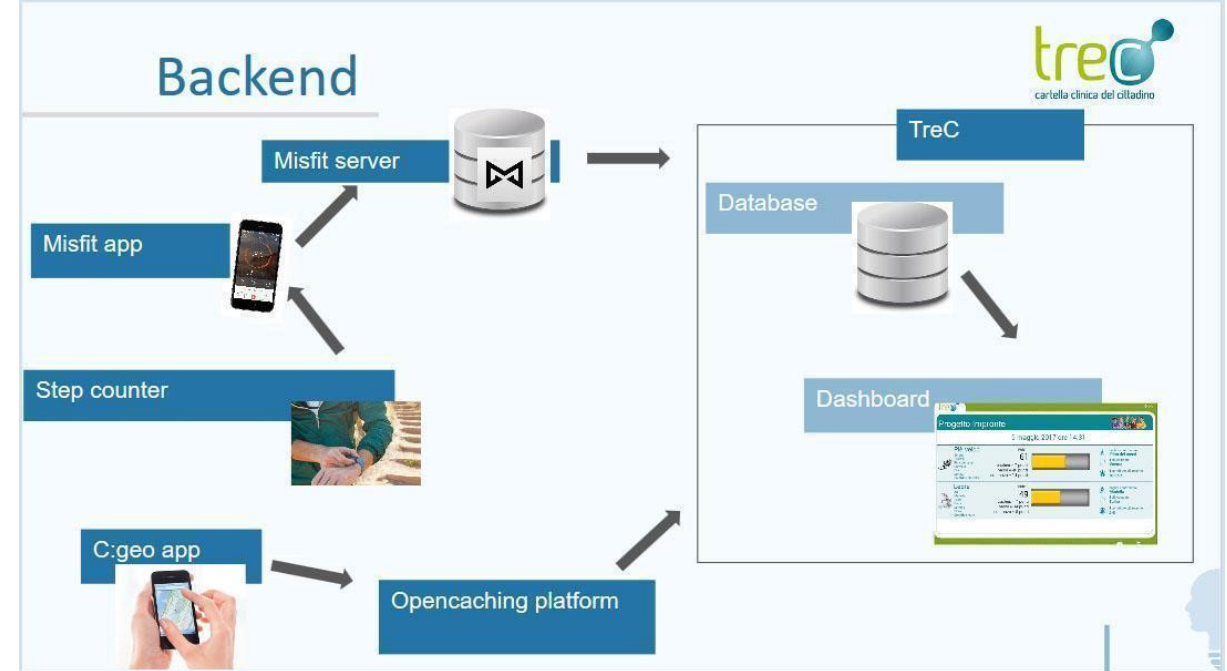
Figure 2. The backend system to collect the steps and the data from the C:Geo app and to show them in the